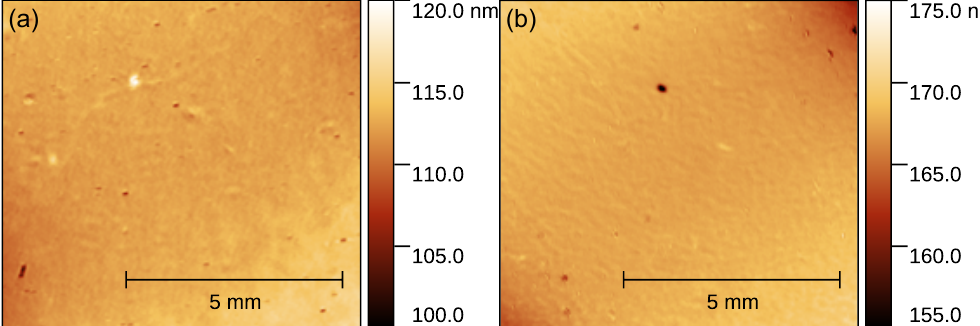
Figure 7. The map of the local thicknesses determined by ISR for: Sample 1 ( a ); and Sample 2 ( b ).